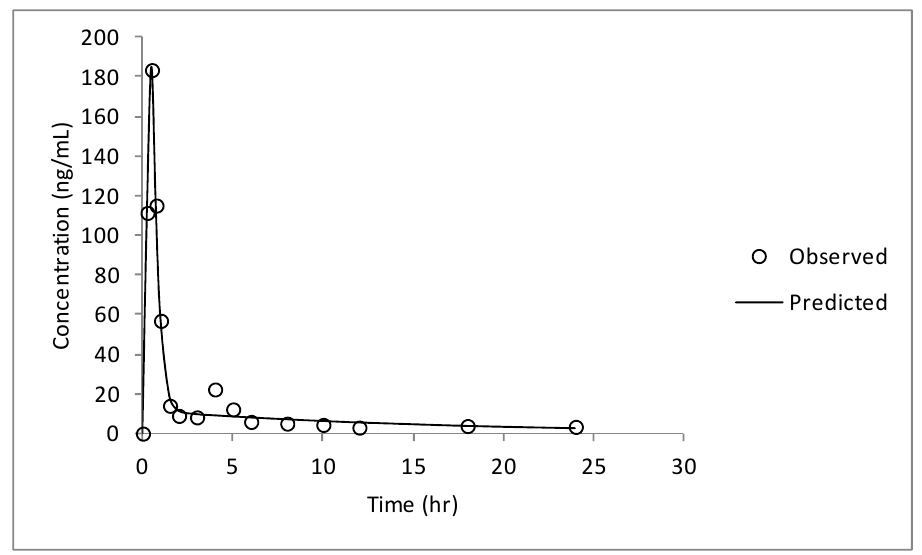
Figure 6. Plot of predicted and observed plasma concentration vs. time profile for CRM-LF for two-compartment model with lag time.